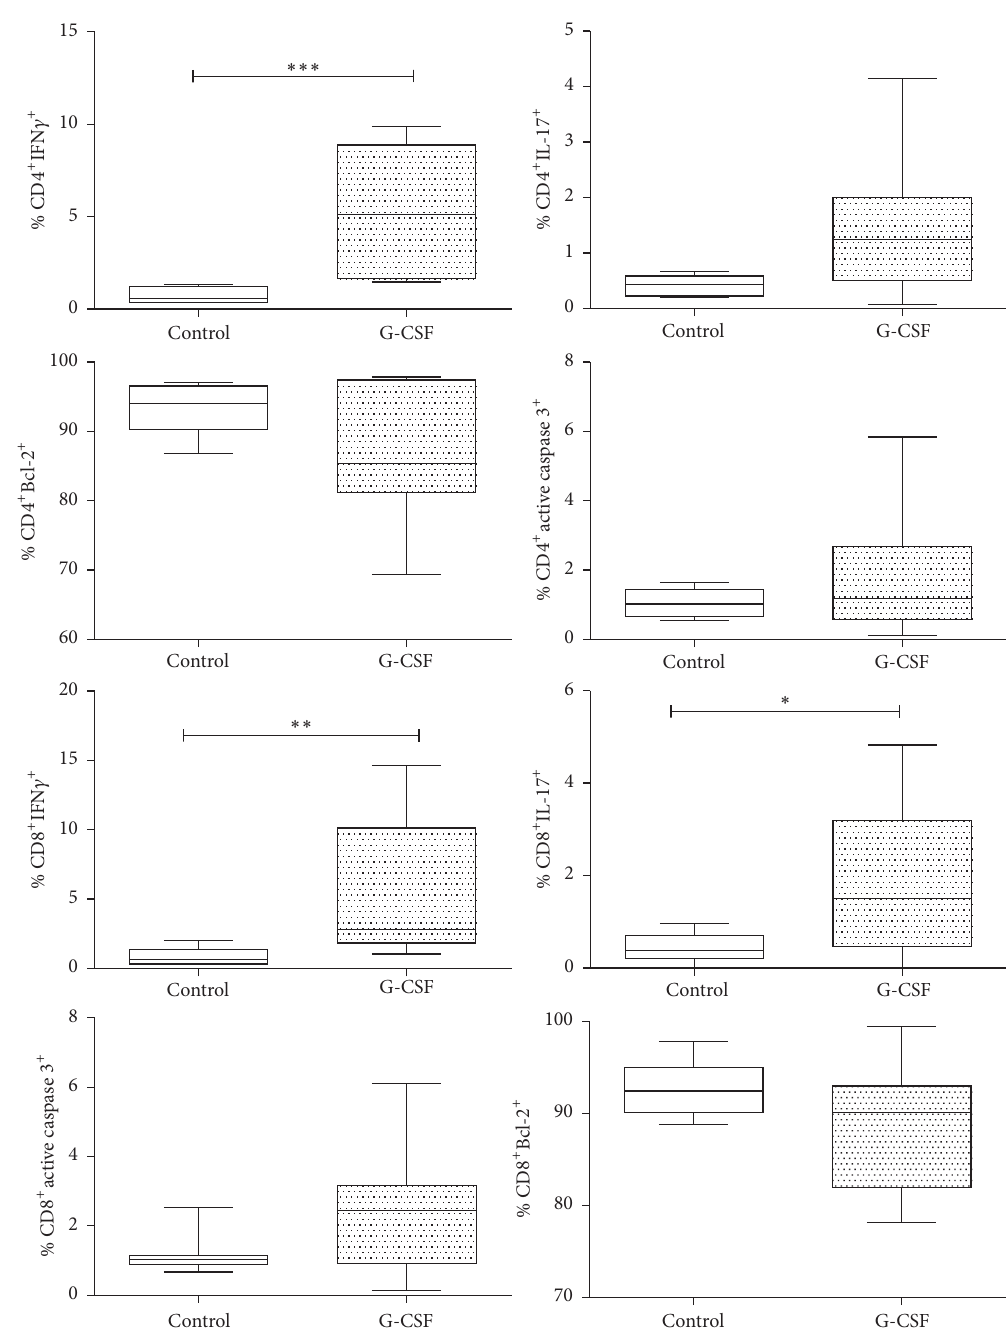
Figure 2: Cell viability and proinflammatory cytokines in healthy donors mobilized with G-CSF. Determination of IFN 𝛾 , IL-17, Bcl-2, and active caspase-3 in peripheral blood CD4 + and CD8 + cells from a control group ( 𝑛 = 6 ) and a group of G-CSF-mobilized donors ( 𝑛 = 8 ). Box plots show population distribution and whiskers denote one standard deviation. A significant increase in the number of CD4 + IFN 𝛾 + (Th1), CD8 + IFN 𝛾 + (Tc1), and CD8 + IL-17 + (Tc17) cells is observed; this increase is not significant in CD4 + IL-17 + (Th17) cells, but a marked tendency is shown ( 𝑝 = 0.06 ). ∗ 𝑝 < 0.05 ; ∗∗ 𝑝 < 0.01 ; ∗∗∗ 𝑝 < 0.001